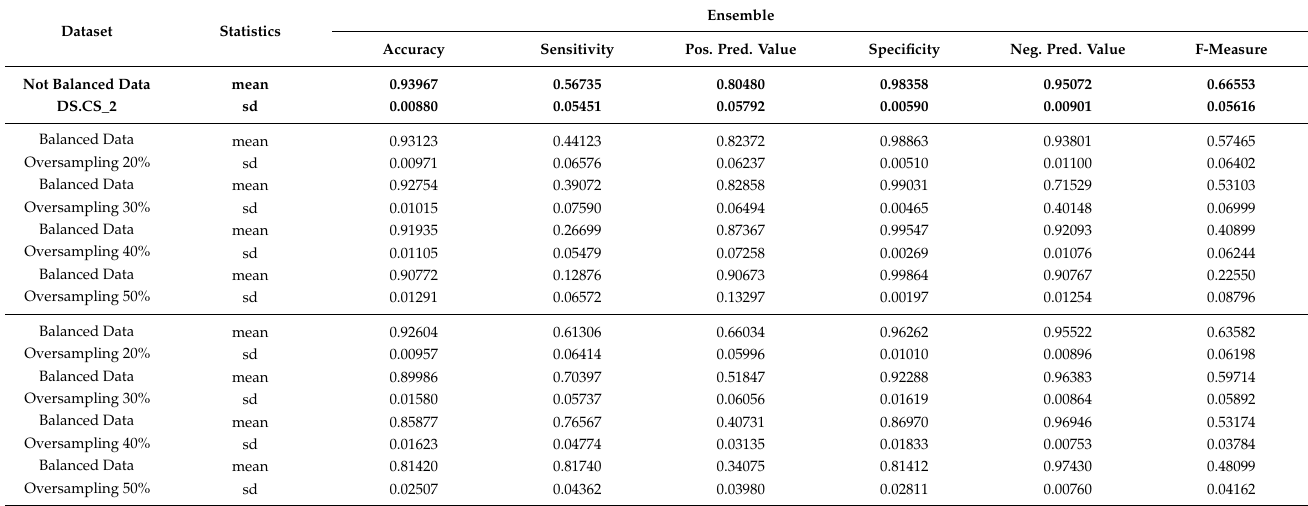
Table 7. Data balancing evaluation: